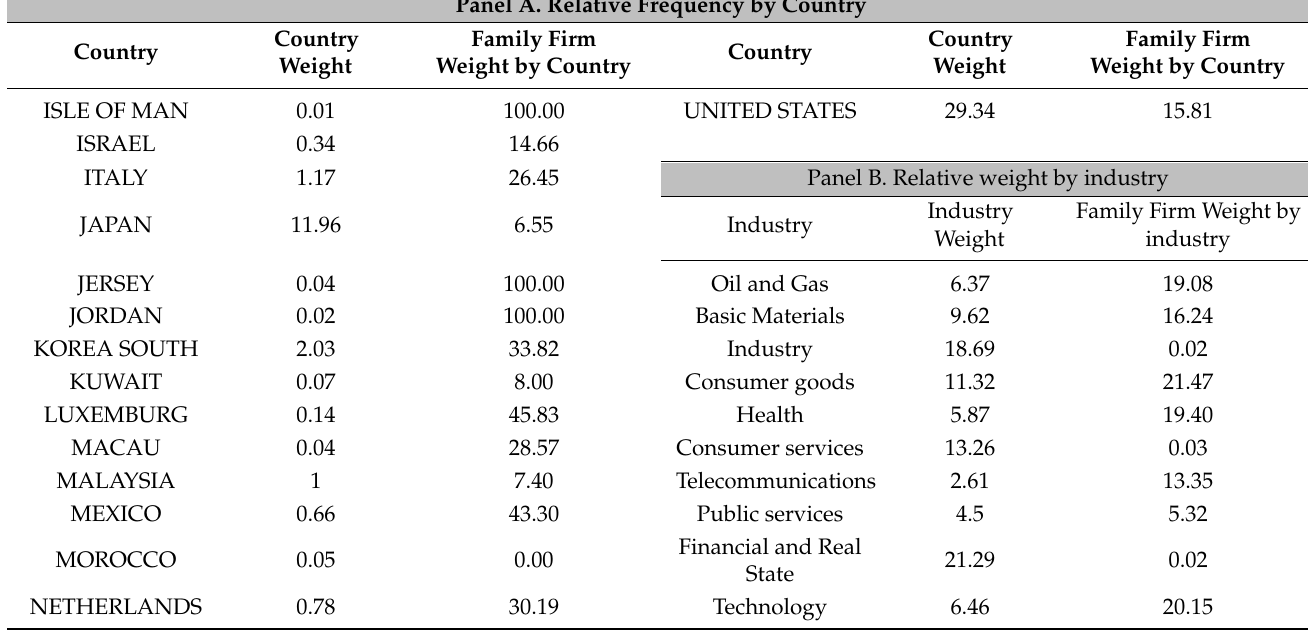
Table 1. Cont . Panel A. Relative Frequency by